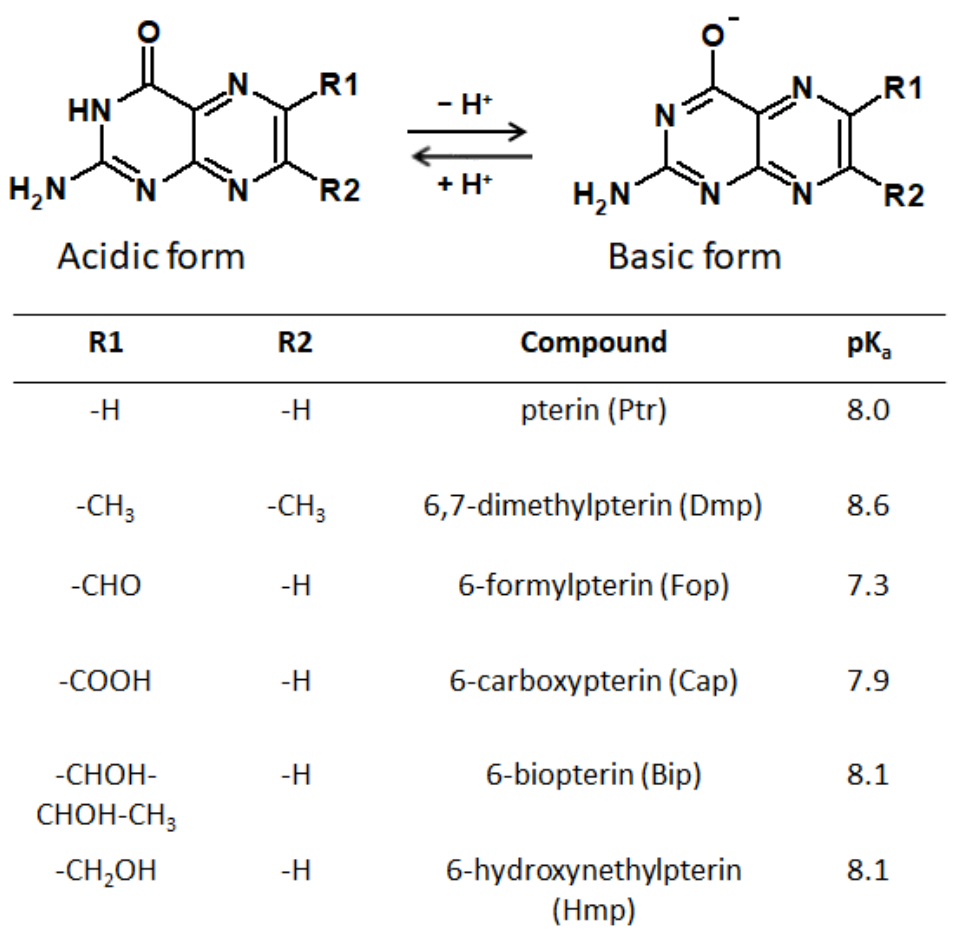
Figure 10. Structure and pK a values for acid-basic equilibria of oxidized pterins in aqueous solutions [172].